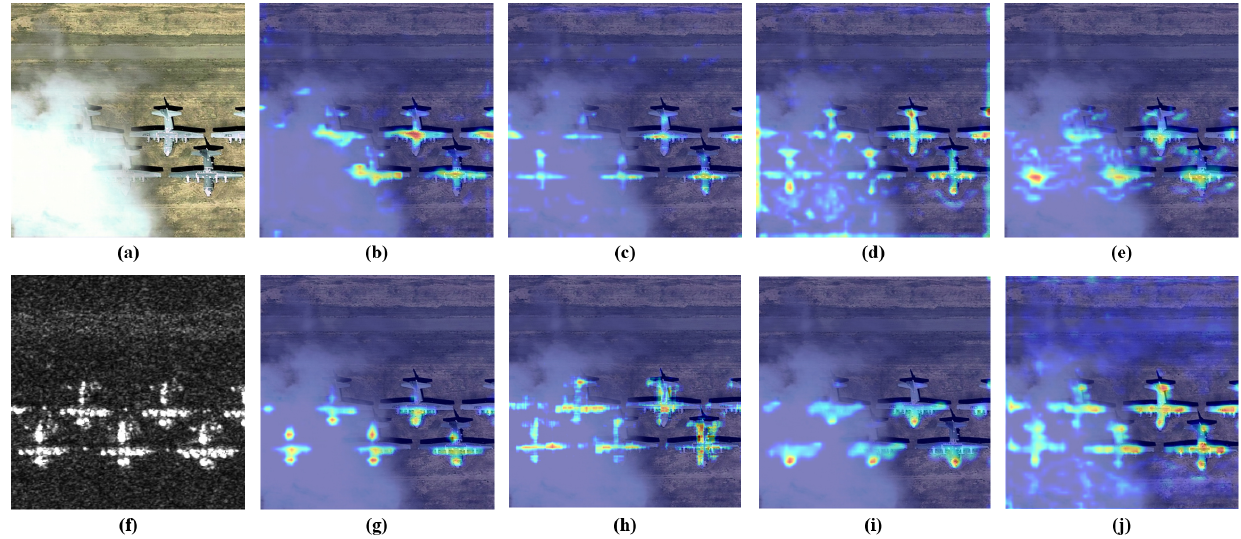
Figure 12. ( a ) Optical images, ( f ) SAR image and heat map of different models features: ( b ) optical image, ( c ) Sum Fusion, ( d ) Max Fusion, ( e ) Concat Fusion, ( g ) SAR image, ( h ) CIAN, ( i ) MCFF, ( j )